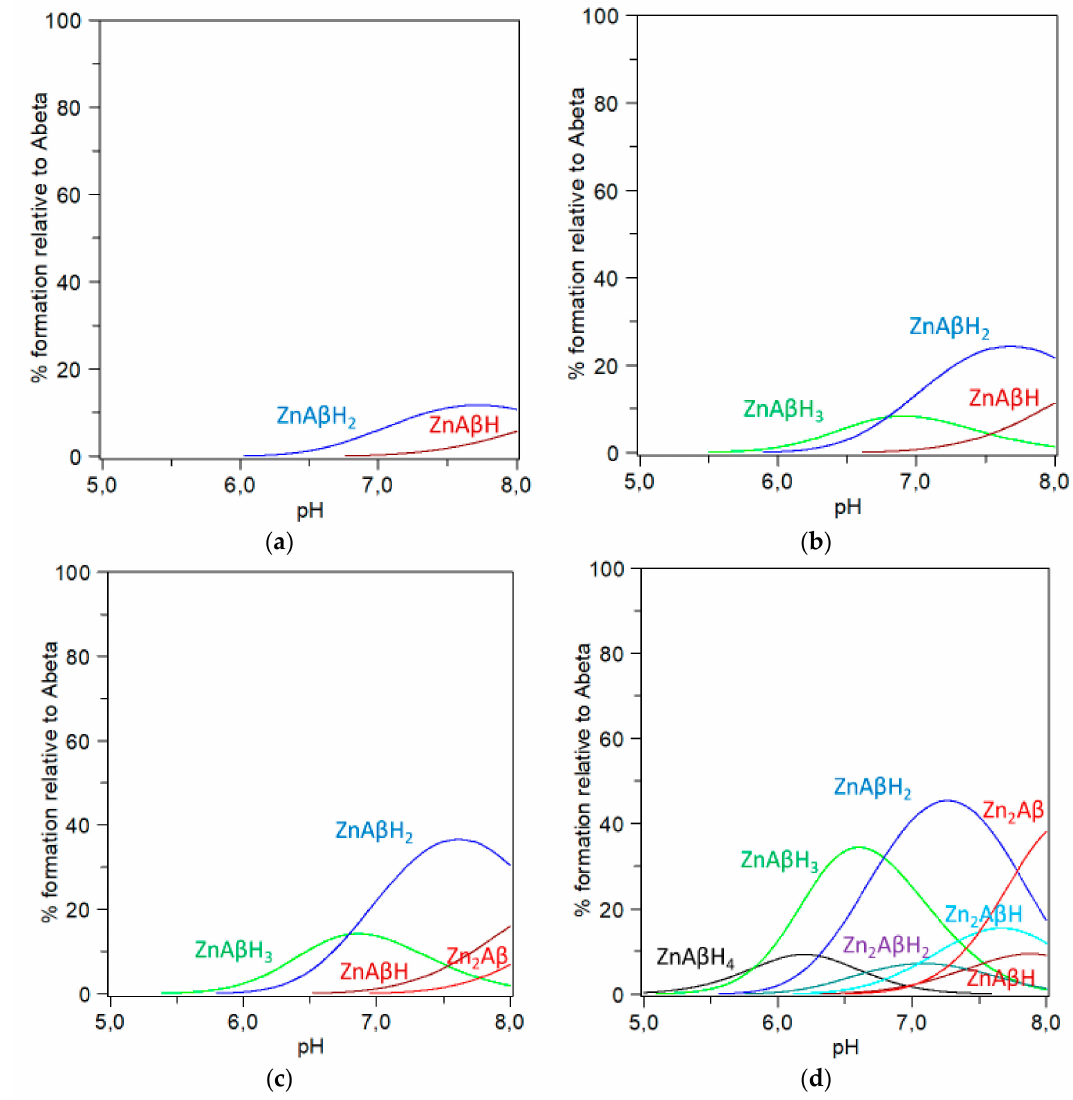
Figure 3. Computed species distribution mimicking the assays by Yoshiike et al. [29] who investigated the concentration dependent inhibition of β -aggregates (ThT test) and the increase of cell (MTT test). Figure 3a–d reproduce the addition of Zn 2 + to A β (1–16)PEG in 20 mM TRIS bu ff er at pH 7.4, t = 25 ◦ C; C A β = 5 µ M in all diagrams; ( a ) C Zn = 2 µ M; ZnA β H 2 (blue line), ZnA β H (amaranth line); ( b ) C Zn = 5 µ M, ZnA β H 3 (green line), ZnA β H 2 (blue line), ZnA β H (amaranth line); ( c ) C Zn = 10 µ M, ZnA β H 3 (green line), ZnA β H 2 (blue line), ZnA β H (amaranth line), Zn 2 A β (red line); ( d ) C Zn = 70 µ M, ZnA β H 4 (black line), ZnA β H 3 (green line), ZnA β H 2 (blue line), ZnA β H (amaranth line), Zn 2 A β H 2 (fuchsia line), Zn 2 A β H (turquoise line), Zn 2 A β (red line). A β (1–16) PEG protonation constants from reference [37]; TRIS protonation, Zinc-TRIS formation and Zn 2 + hydrolysis constant from reference [96]. Species percentage was computed by using HYSS